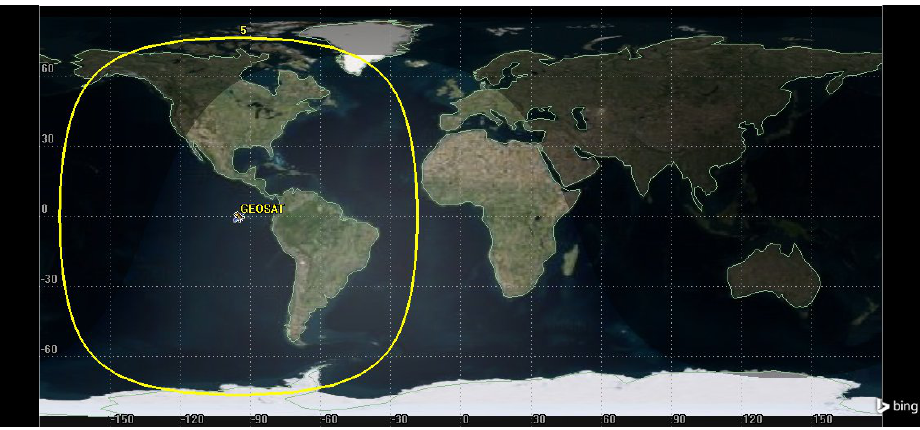
Figure 1. Approximate coverage of a geostationary satellite located at 91 ◦